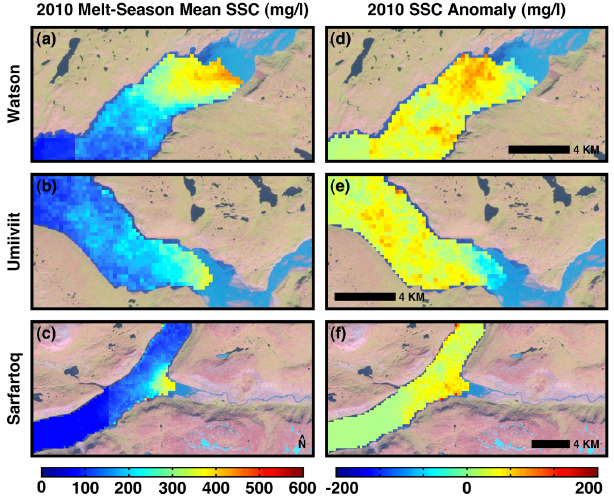
Figure 12. Maps of 2010 melt-season mean suspended sediment concentration (SSC msm ) and its anomaly from its 13 year mean for plume regions of interest. Landsat 7 false color image from 7 July 2001 underlaid for reference.